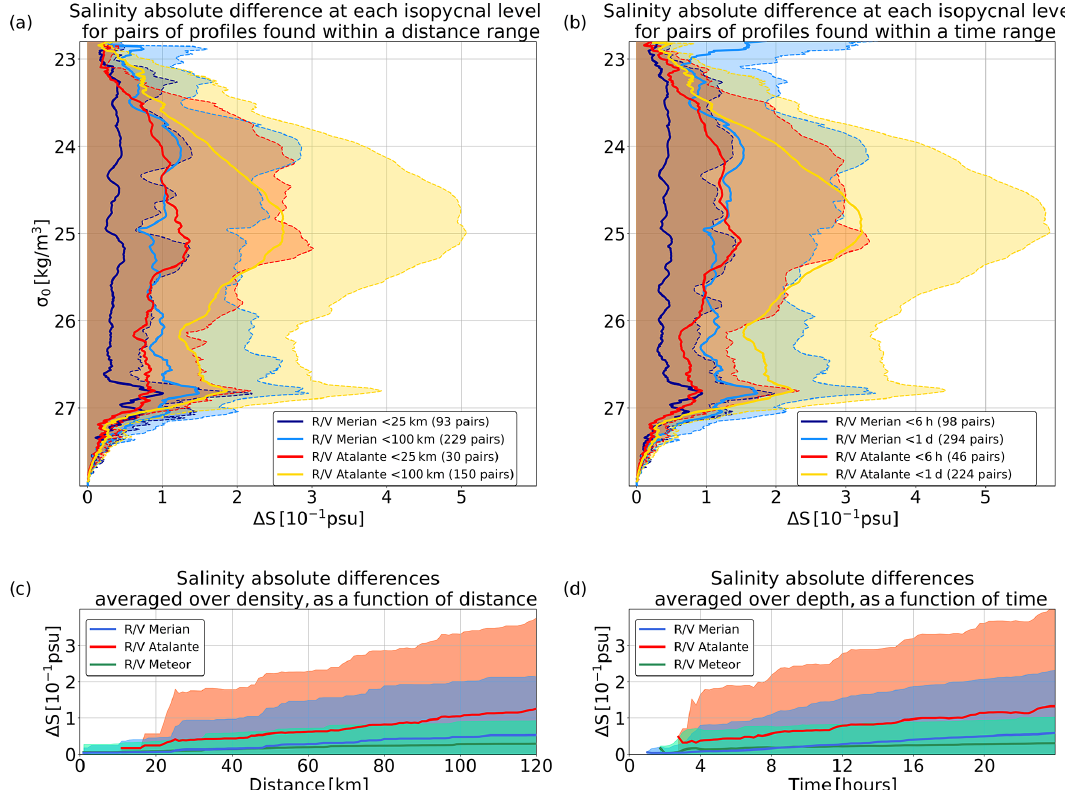
Figure 5. (a) Absolute salinity difference between CTD pairs of profiles calculated on isopycnal levels for each R/V, averaged by distance. The dark blue and red curves are the average differences for profiles that are separated by less than 25km for R/Vs Maria S. Merian and L’Atalante , respectively, while the blue and orange curves are for profiles found within 100km. The shaded areas represented the standard deviation at each isopycnal level. (b) Same as panel (a) but with profiles averaged by time. The dark blue and red curves are for profiles separated by less than 6h, while the blue and orange curves are found within the same day, again for R/Vs Maria S. Merian and L’Atalante , respectively. (c) Absolute salinity differences averaged vertically over the isopycnal levels as a function of distance for R/Vs Maria S. Merian (blue), L’Atalante (red), and Meteor (green). (d) Same as panel (c) but as a function of time instead of